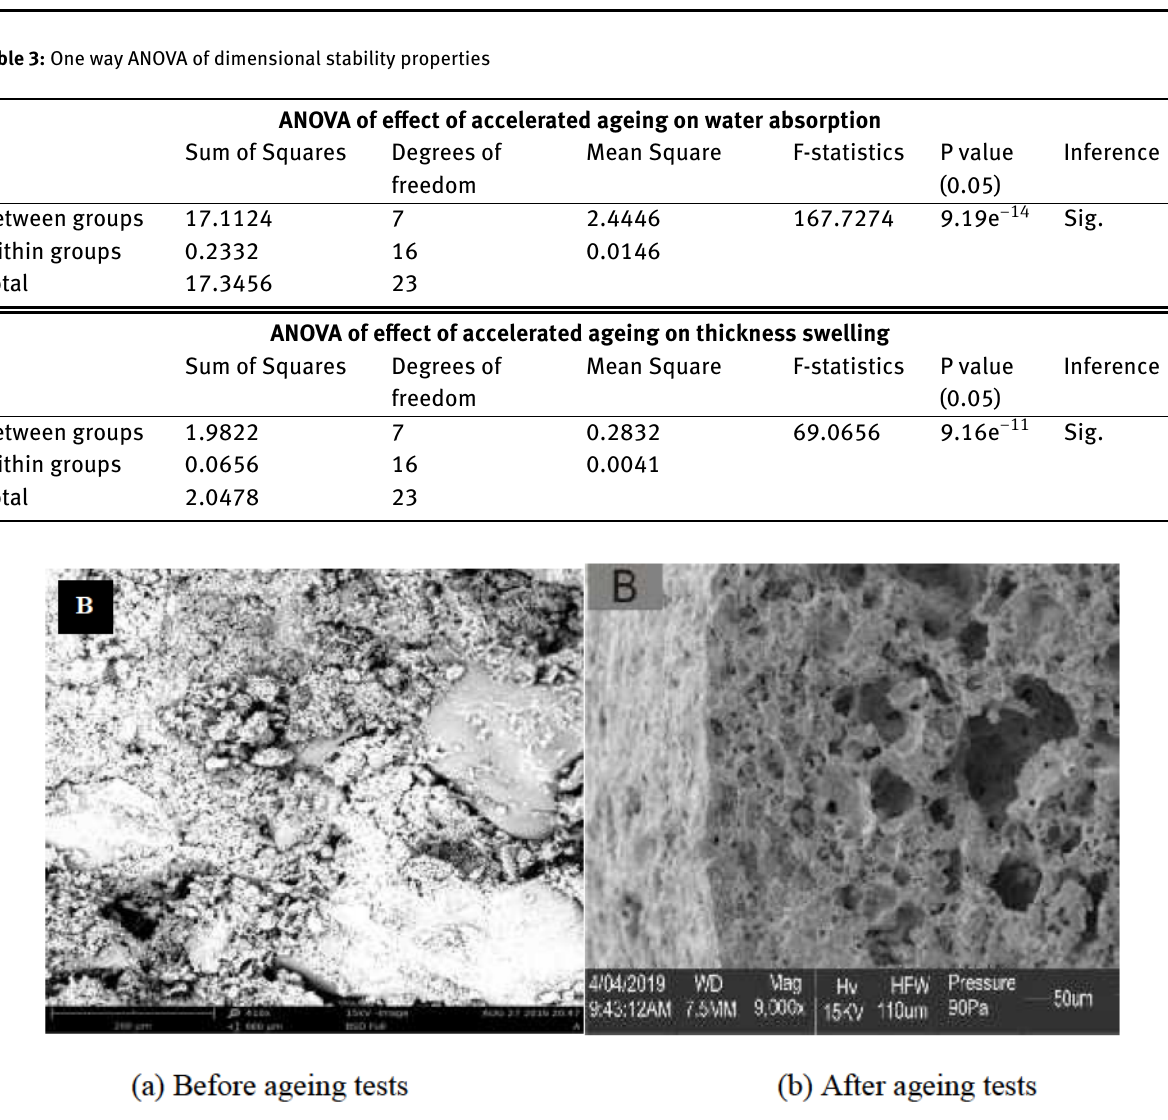
Figure 5: Sample B